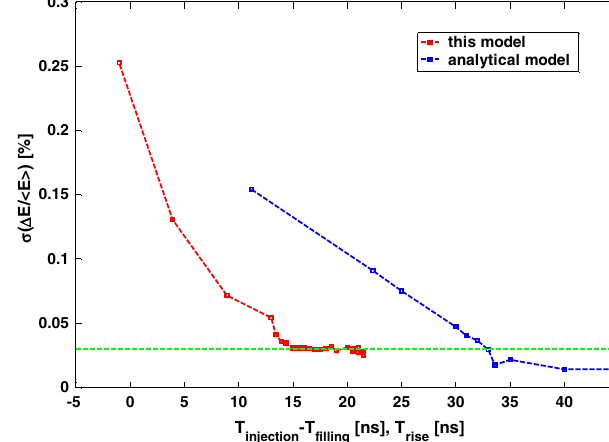
FIG. 17. Relative energy spread along the bunch train for the optimized CLIC pulse, (cid:1) ¼ 0 : 025% .